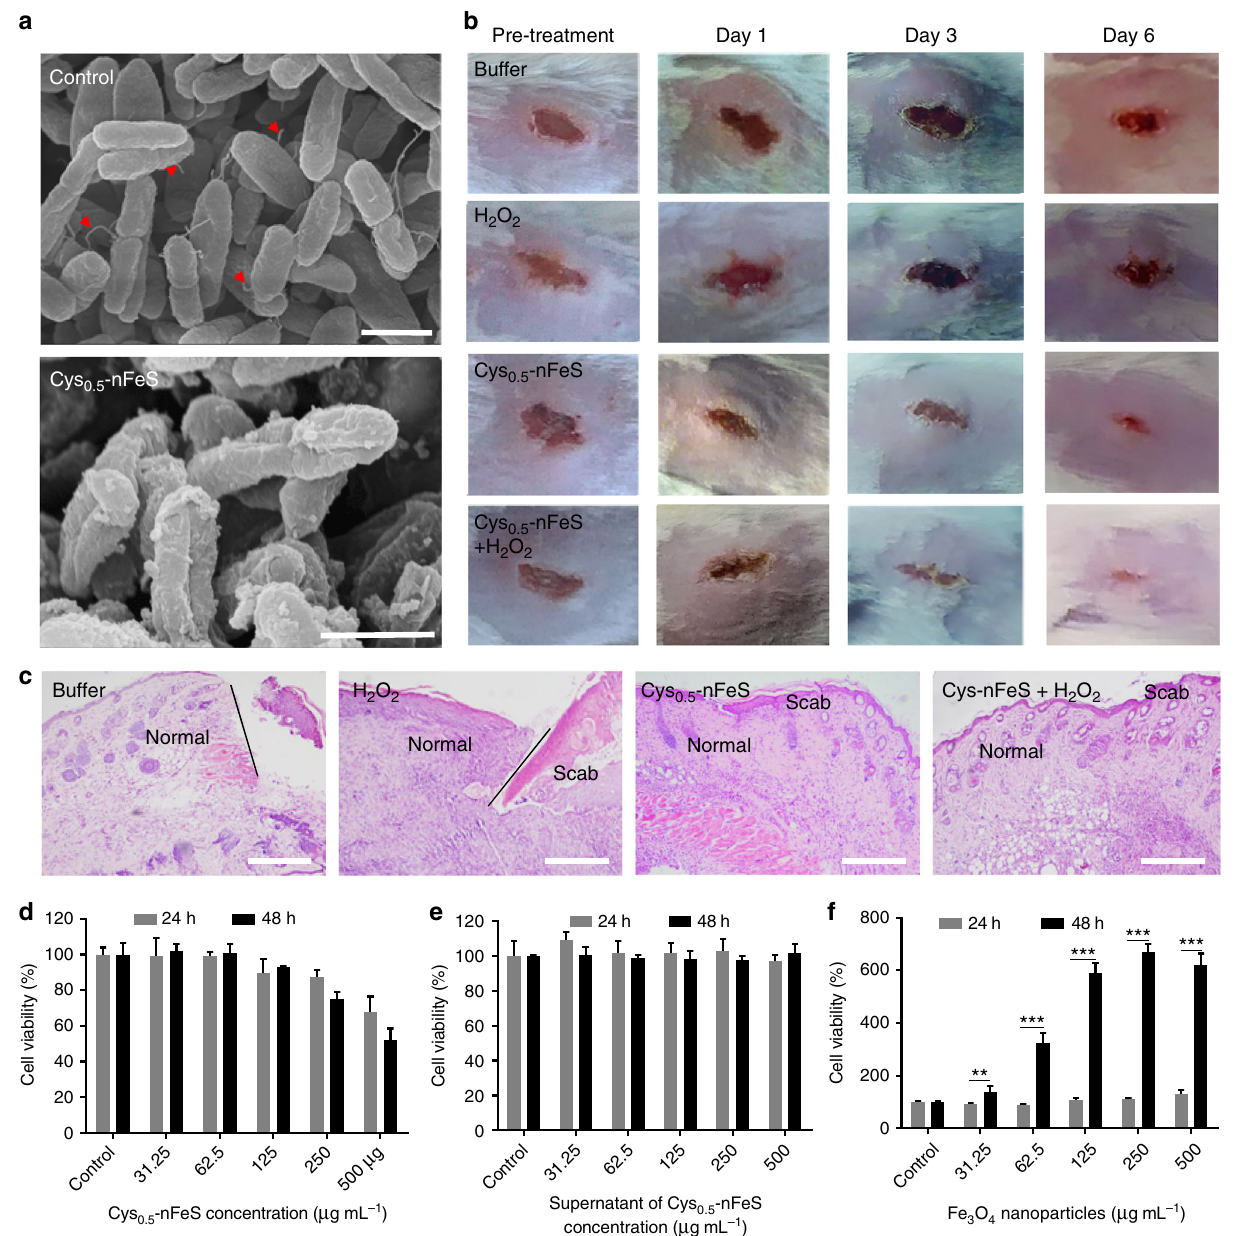
Fig. 5 Infected-wound healing using nFeS regimen. a Morphology of P. aeruginosa before (control) and after Cys-nFeS treatment. The red triangles indicate fl agella. Scale bars: 1 µ m. b Photographs of P. aeruginosa infected wounds treated with buffer (control), Cys-nFeS, H times ( fi ve mice in each group). c Histologic analyses of the corresponding treated wounds in ( b ) at day 6. Scale bars: 500 µ m. d In fl uence of Cys-nFeS on the viability of fi broblast cells. e In fl uence of the supernatant from Cys-nFeS on the viability of fi broblast cells. f Stimulation of fi broblast cell proliferation by Fe 3 O 4 nanoparticles. Data are shown as the mean ± s.d. Statistical signi fi cance was assessed using an unpaired Student ’ s two-sided t -test compared to the control group. ** p < 0.01, *** p < 0.001 and **** p < 0.0001. Mean values and error bars were de fi ned as mean and s.d., respectively. All experiments